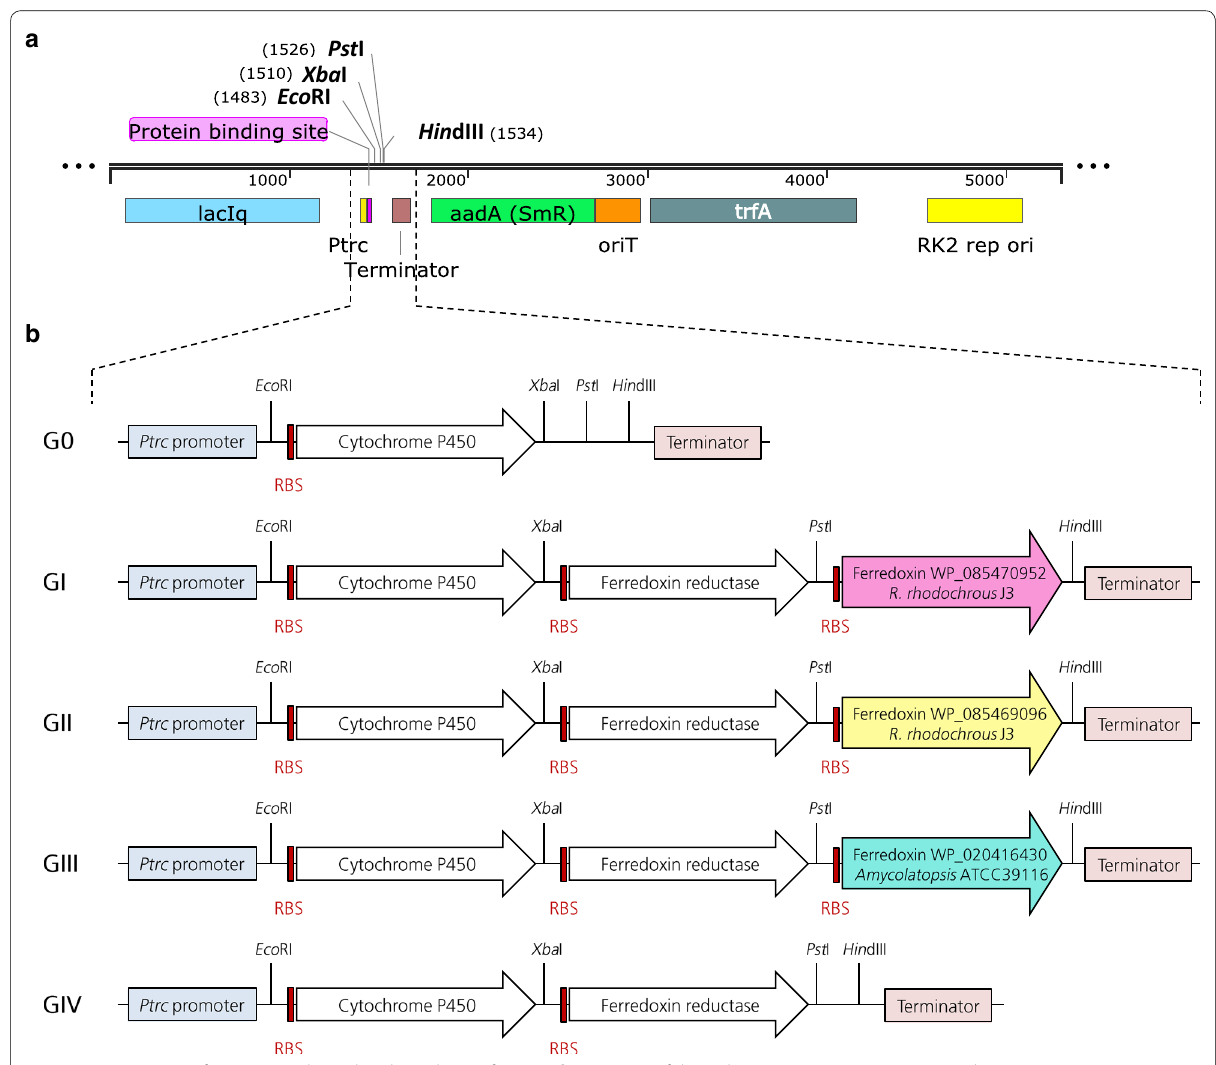
Fig. 2 a Linear map of pSEVA424 plasmid and its relevant features. b Structure of the polycistronic operons constructed in pSEVA424. Strains GI, GII, and GIII contain all three gene elements, strain G0 only carries the first gene (CYP gene), and strain GIV contains the first two genes only. Strains GI–III differ by the origin of the ferredoxin gene (WP_085470952 from R. rhodochrous J3 in GI, WP_085469096 from R. rhodochrous J3 in GII and WP_020416430 from Amycolatopsis ATCC 39116 in